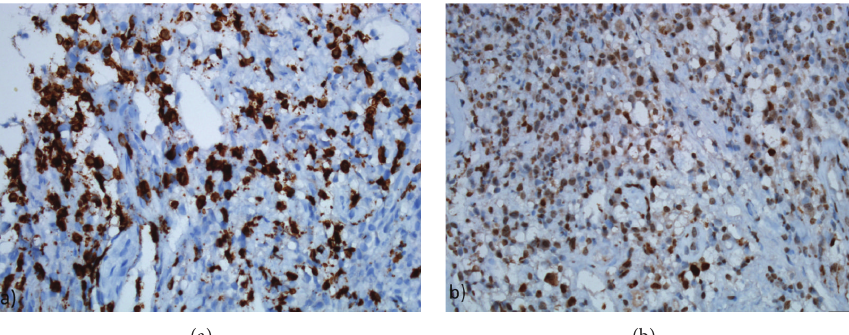
Figure 6: (a) The neoplastic B lymphoid cells also show diffuse MUM-1 positivity (MUM-1 immunostain, × 400). (b) Ki-67 index was